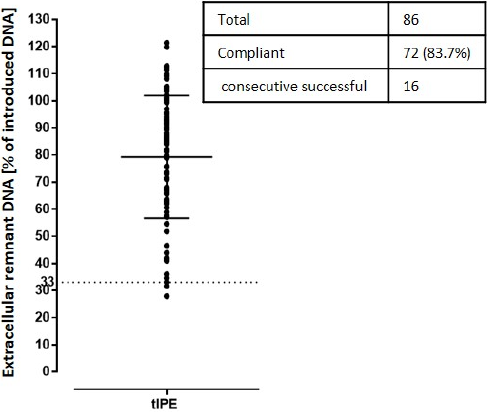
16 of 25 Figure 7. Cell viability of tIPE and non ‐ transfected control cells. ( A ) There was no difference in the percentage of viable cells between tIPE and controls (tIPE: 31.92 ± 19.04%; Co ‐ 1: 30.062 ± 12.04%; Co ‐ 2: 28.02 ± 11.40%) ( p > 0.999). ( B ) Individual analysis of the iridectomies i01–i04 showed that cell viability did not decrease during the time elapsed while processing one eye (i01: 41.46 ± 21.45%; i02: 29.35 ± 18.48%; i03: 29.23 ± 18.46%; i04: 28.64 ± 14.18%) ( p = 0.2360). Remnant extracellular DNA. After transfection, remnant extracellular DNA was re ‐